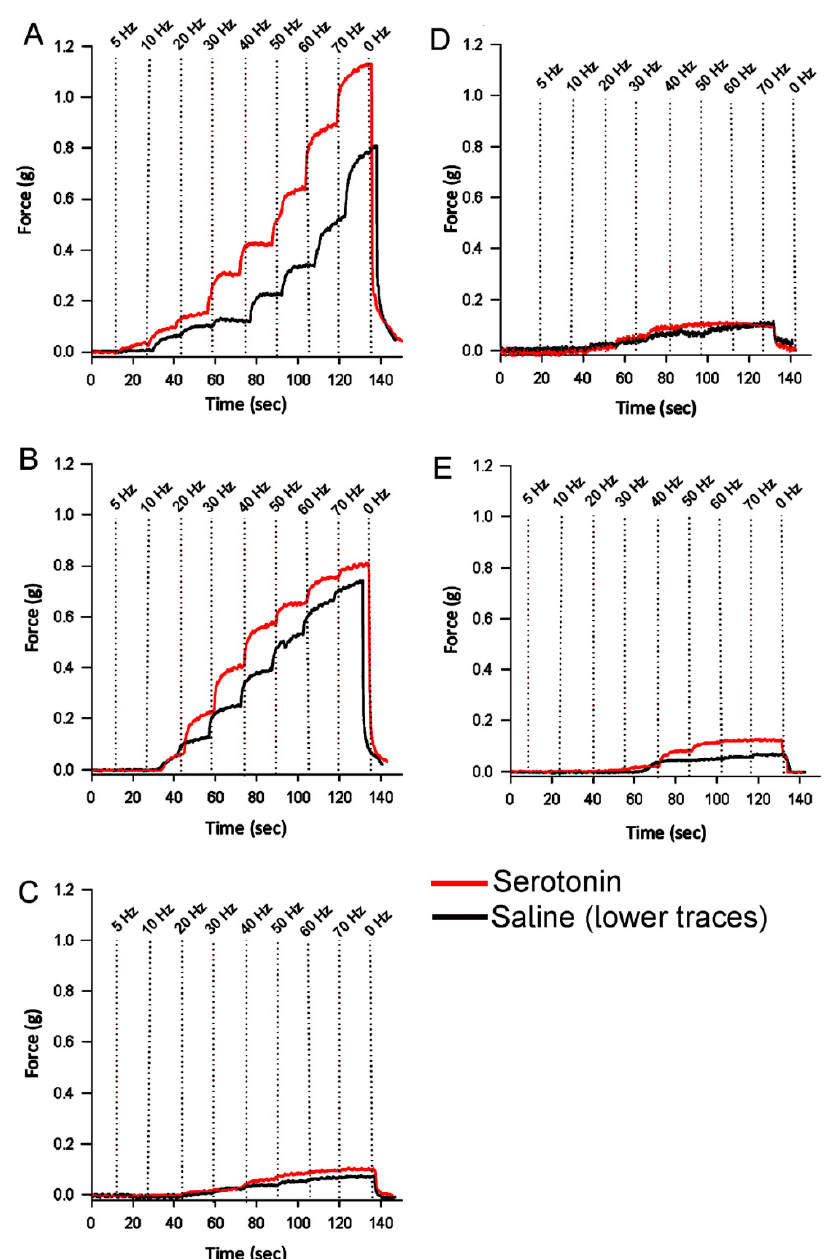
Figure 11. Representative traces of force generation before and after exposure to serotonin: In each graph, the black trace (lower trace) represents the force generated by fibers without serotonin and the red trace (upper trace) represents the force generated in the presence of serotonin. Serotonin increased the force generated in each of the different preparations: ( A ) the control, ( B ) ablated distal fibers, ( C ) ablated central fibers, ( D ) concurrently ablated distal and central fibers, and ( E ) ablated distal then central fibers.